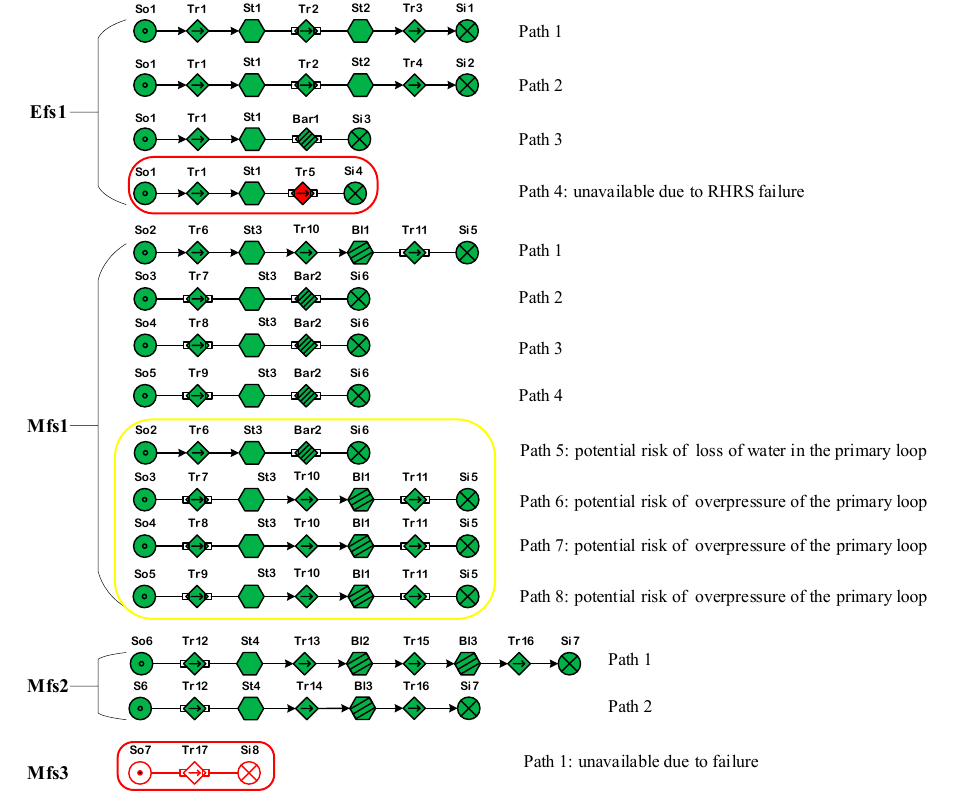
Figure 8. Paths identified from the MFM model in Figure 7. Table 3. Explanation of each identified